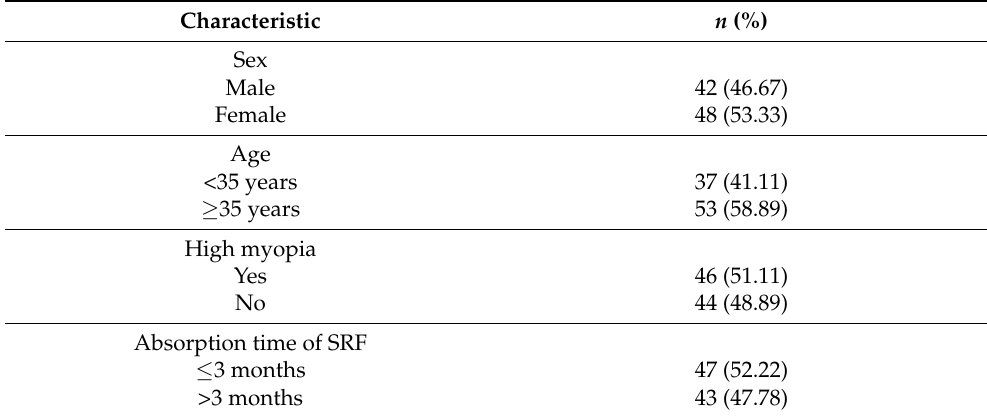
Table 1. General information of